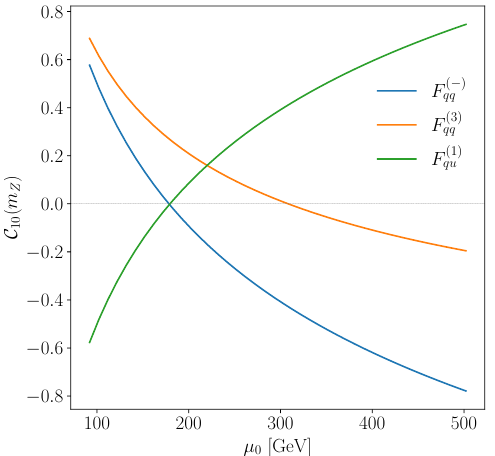
Figure 9 . SMEFT contributions of four-quark coefficients F i ( µ 0 ) in MFV to C 10 ( m Z ) as a function of the high scale µ and matched onto C